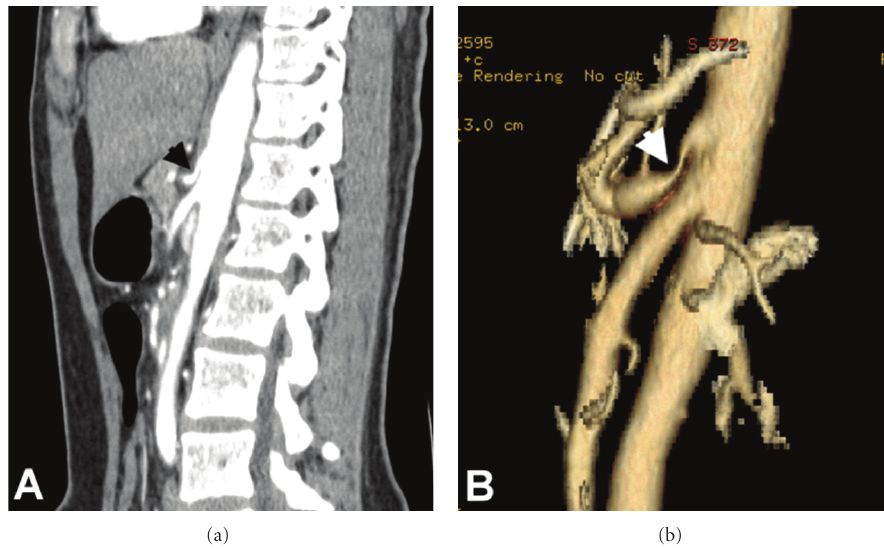
Figure 1: Computed tomography angiography of the celiac artery compression syndrome demonstrated the characteristic hooked narrowing of the proximal celiac artery with poststenotic dilatation in 2D reconstruction image (a, arrow) and 3D reconstruction image (b, arrow).